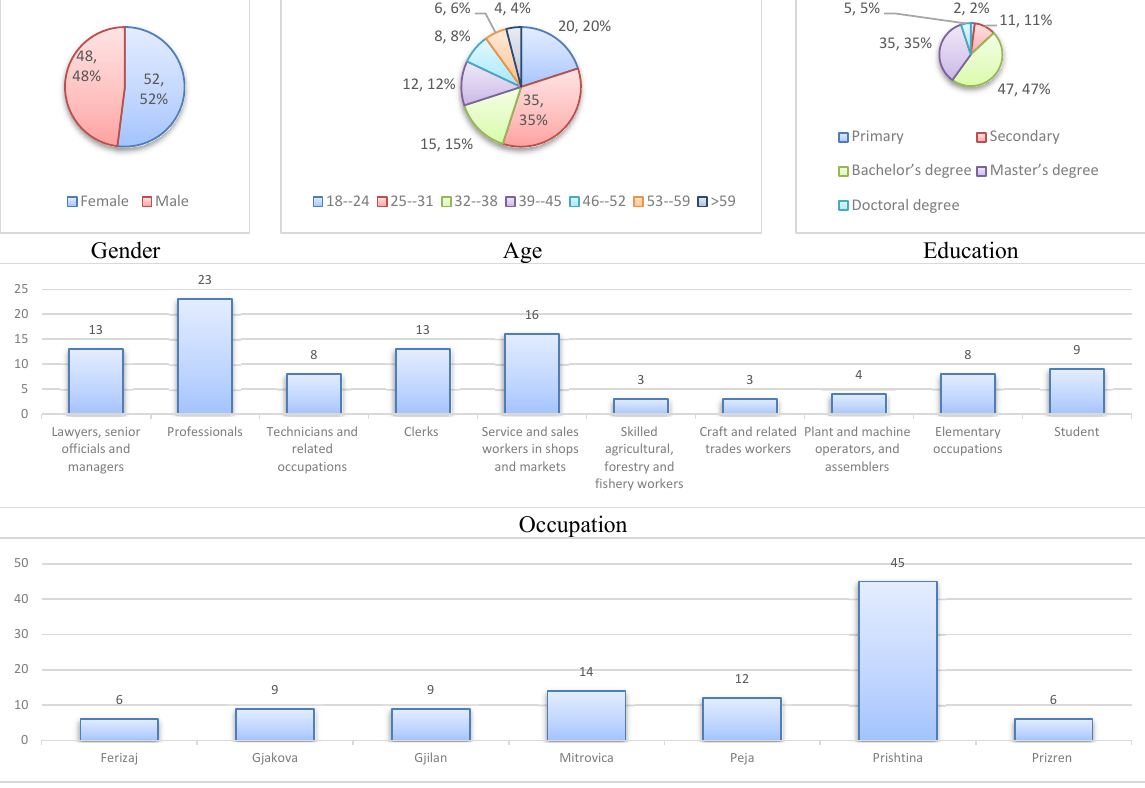
Fig. 2 . Respondent